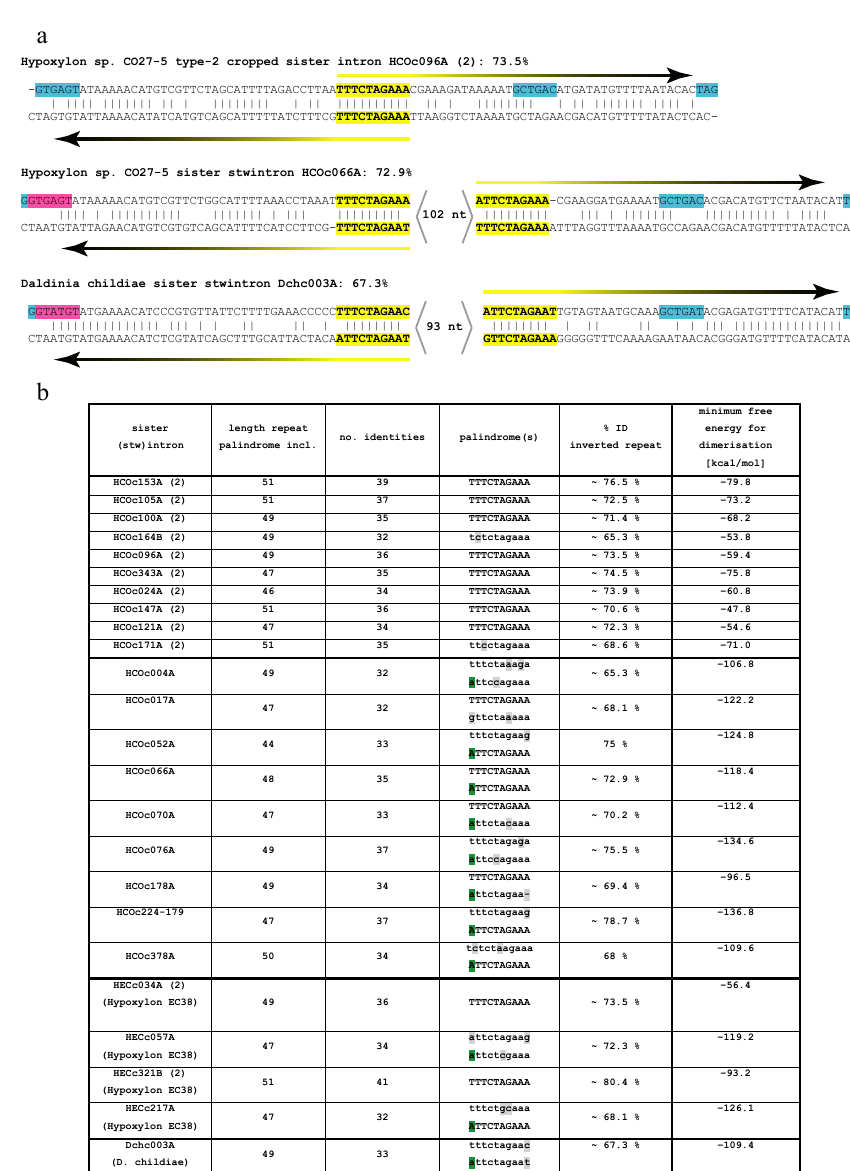
Figure 4. Terminal symmetry in type-2 cropped sister introns and sister stwintrons. ( a ) Examples of type-2 cropped sister introns and sister stwintrons aligned with their own reverse complement sequence to show considerable terminal symmetry. Clustal-Omega was run with default settings. The 5 (cid:48) -donor, BP and 3 (cid:48) -acceptor elements of the internal (magenta) and external (turquoise) introns are highlighted on the coding strand. Terminal repeats (44–55 nt) are indicated by the horizontal arrows. The 10-nt palindrome (5 (cid:48) -WTTCTAGAAA) is highlighted in yellow. For the sister stwintrons, the space between the two copies of the 10-nt palindrome—including the internal splice sites—is indicated: <nt>. The percentages of nt identity of the terminal repeats are given for each of the three sister (stw)introns shown as examples. ( b ) The percentage of identity of the terminal inverted repeat in all 10 type-2 sister introns and the 9 least divergent sister stwintrons. Corresponding data for four sister (stw)introns in Hypoxylon sp. EC38 are included, as well as for one Daldinia childiae sister stwintron, Dchc003A (see Section 3.7). The sequences of the 10-nt palindromes are given in capital letters where perfect: The 5 (cid:48) A in the 3 (cid:48) palindrome copy is highlighted in green and present in all but one of the 12 sister stwintrons analysed. Other divergencies are highlighted in grey. The theoretical minimum free energy of double-stranded sister (stw)intron RNA molecules (right column) was predicted by